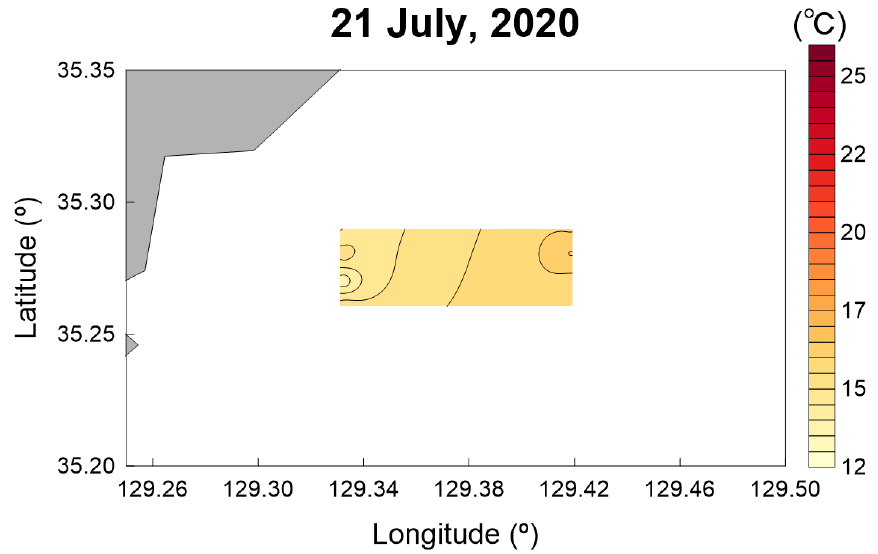
Figure 15. Distribution of temperature in the major swimming layers in the Gijang coastal waters sea (21 July, 2020).